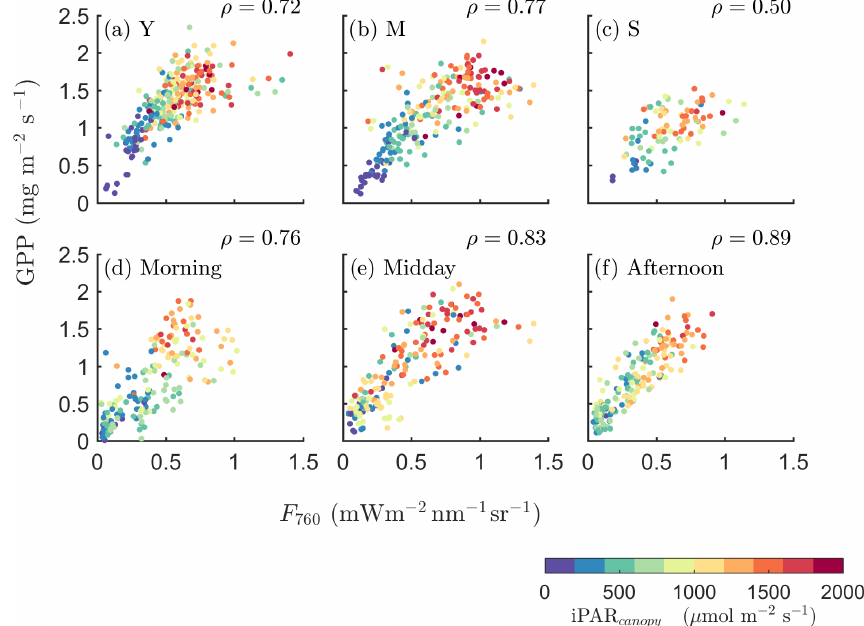
Figure 3. Relationships between far-red SIF ( F 760 ) and GPP of a corn canopy across the 2017 growing season, with a 30min temporal resolution during daytime hours for three growth stages (a–c) , namely young ( Y ), mature ( M ) and senescent ( S ), for three times in 1d (d–f) , i.e., morning (09:00–11:00 local time – LT), midday (11:00–14:00LT) and afternoon (14:00–17:00LT). Colors refer to the iPAR canopy values obtained in conjunction with the GPP and SIF observations, as shown in the legend.